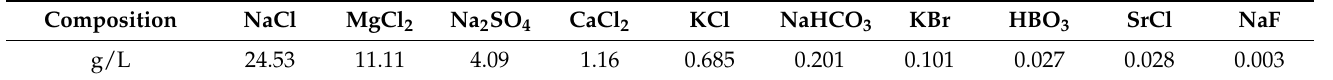
Table 1. The composition of the simulated seawater